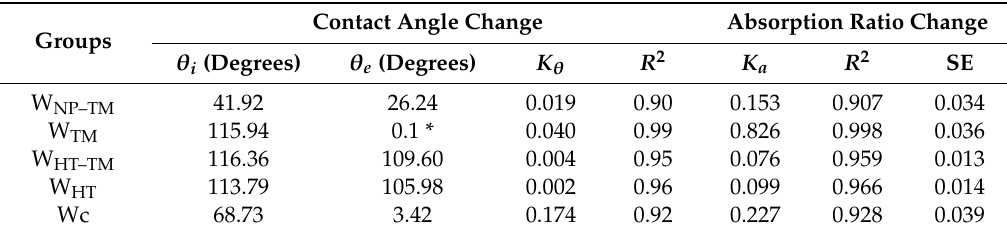
Table 3. Wetting kinetics of water droplets on untreated and combined treated poplar.